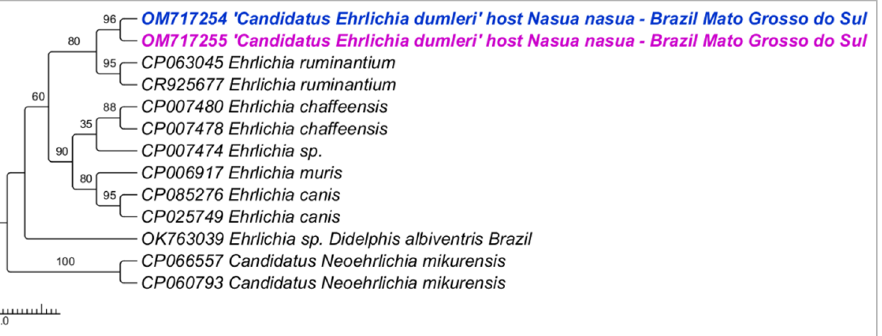
Figure 5. Phylogenetic tree inferred by the Bayesian method and based on the 23S–5S intergenic region from Ehrlichia spp. sequences obtained from blood from ring-tailed coatis ( Nasua nasua ) sampled in Campo Grande city, Mato Grosso do Sul state, Brazil. Sequences detected in the present study are highlighted in bold pink (VBA) and blue (PEP).